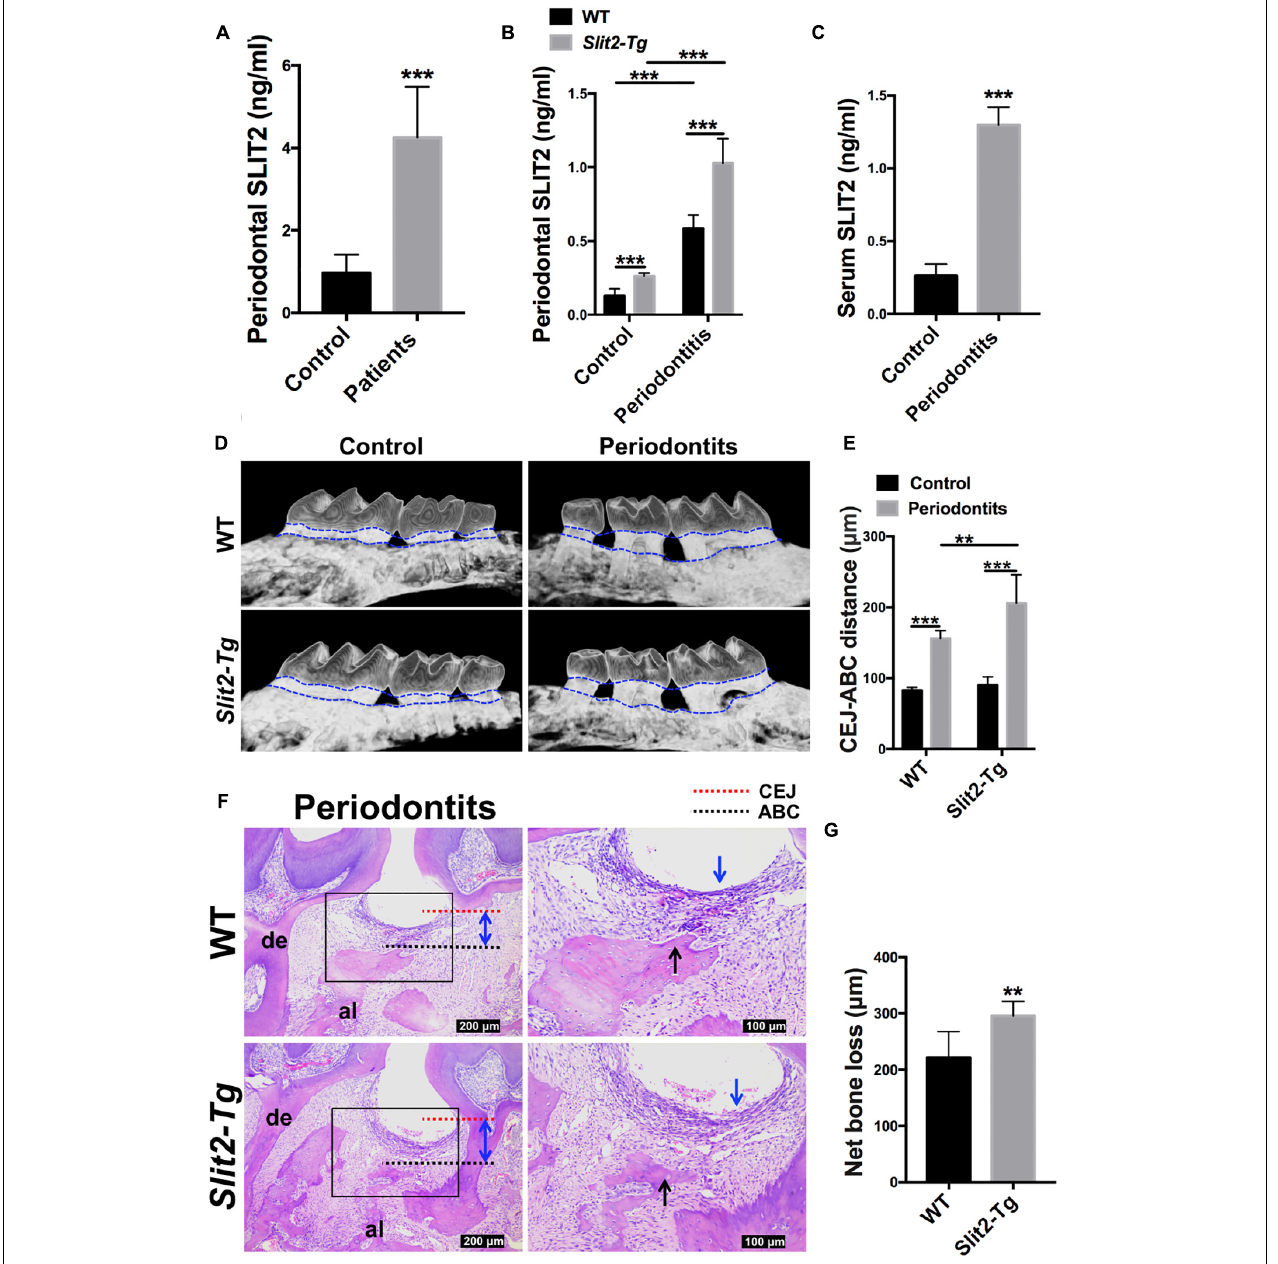
FIGURE 1 | Periodontitis-induced SLIT2 aggravates periodontitis and alveolar bone loss. Expression pattern of SLIT2 protein in, (A) Gingival tissue of periodontitis patients and healthy individuals ( n = 20), and (B) periodontal tissue of healthy and periodontitis wild-type or Slit2-Tg mice. (C) Serum level of SLIT2 protein in wild-type mice ( n = 5). (D) Micro-CT images of healthy and periodontitis-affected alveolar bone with the intact tooth of wild-type and Slit2-Tg mice. (E) Quantitative data of CEJ-ABC distance analyzed from micro-CT images. (F) H&E stained histological images of PAPT of wild-type and Slit2-Tg mice. (G) Quantitative data of alveolar bone loss around the periodontitis-affected tooth analyzed from histological images. Data are presented as mean ± SD ( n = 6). The significant difference among the groups, * P < 0.05, ** P < 0.01, *** P < 0.001. CEJ: cement-enamel junction, ABC: alveolar bone crest, Red dot line: CEJ level, Black dot line: ABC level, al: alveolar bone, de: dentine, blue arrow: inflammatory infiltration of the gingival epithelium, black arrow: alveolar bone resorption, double arrowhead (blue): CEJ-ABC distance, and WT: wild-type.